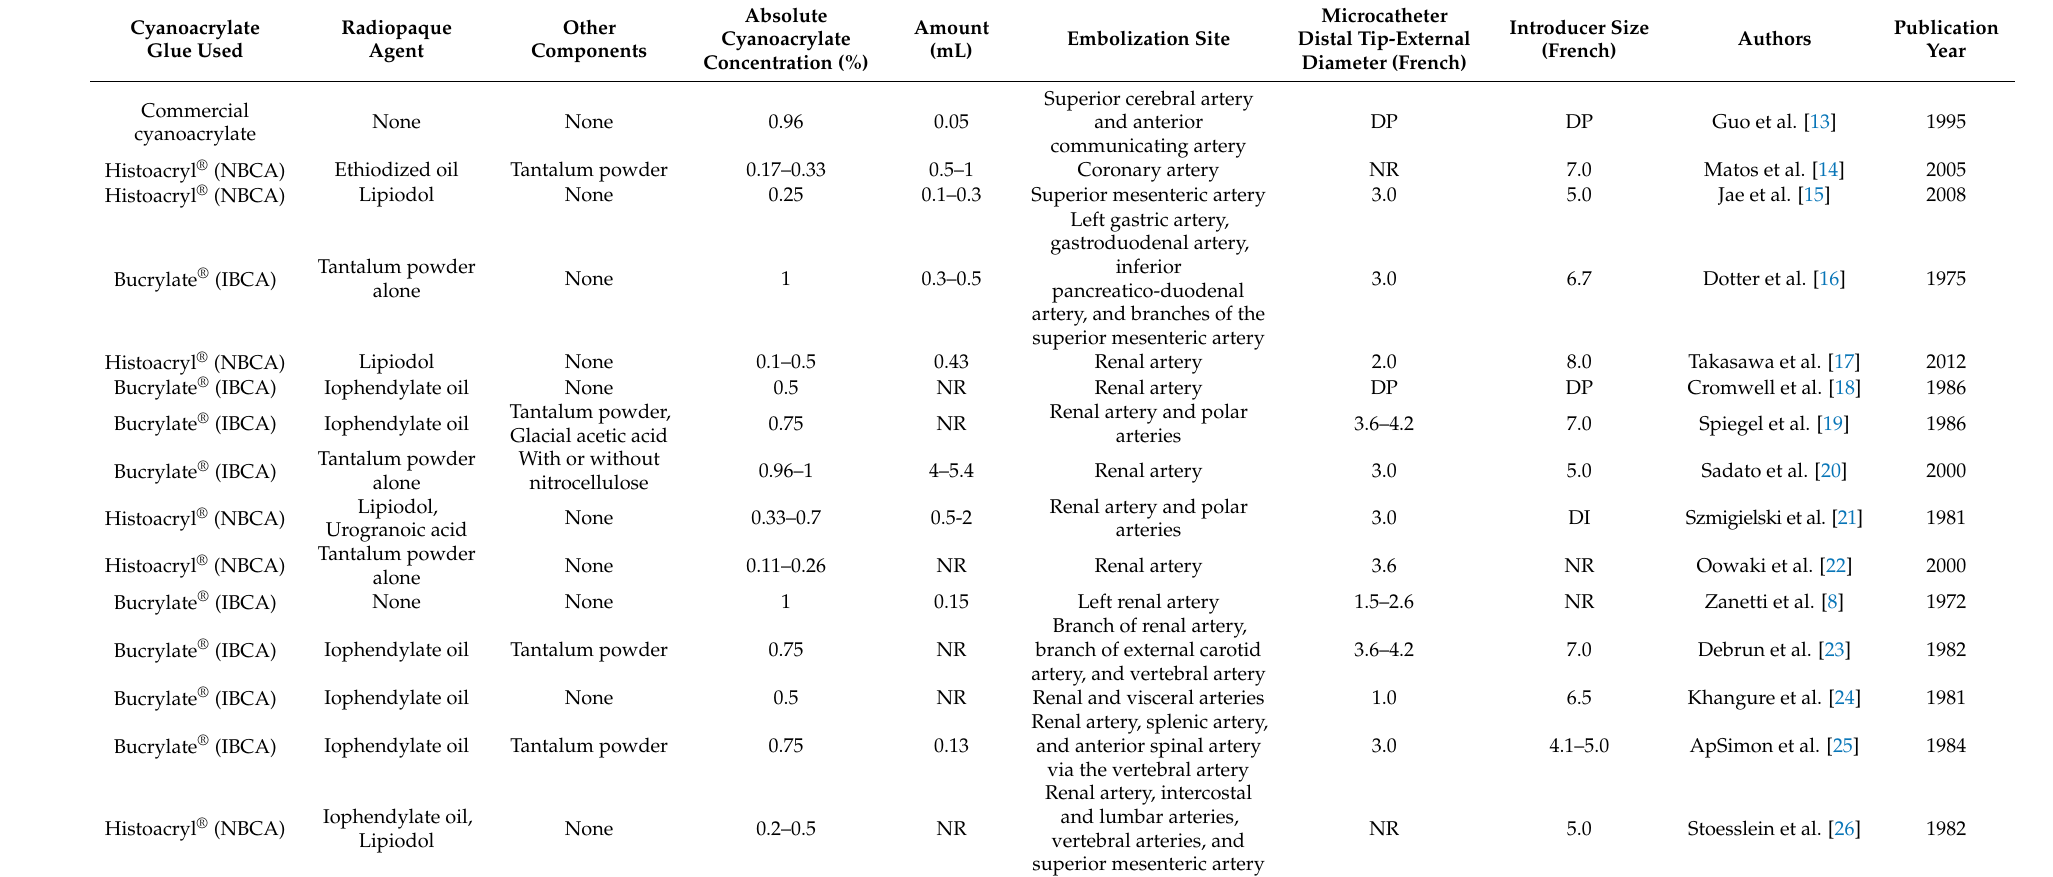
Table 1. Quantitative data from studies of dog